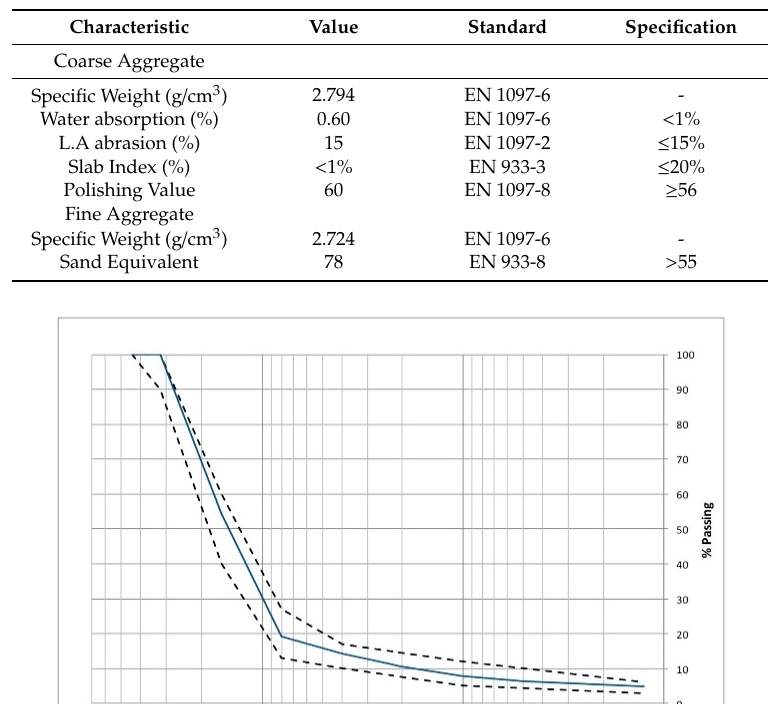
Table 3. Physical properties of coarse (ophite) and fine (limestone) aggregates.